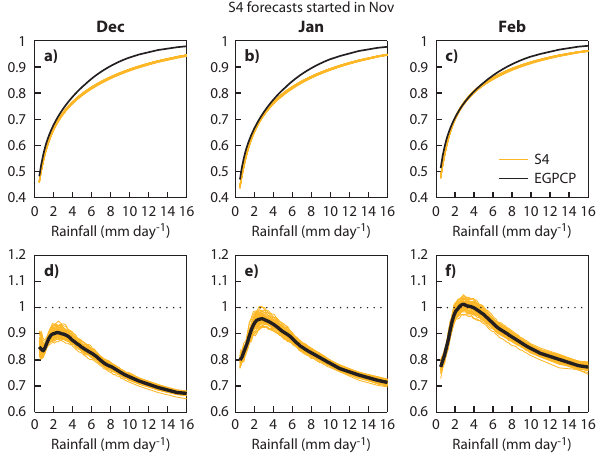
Figure 4. Cumulative density function (CDF) (a–c) of daily precipi- tation from EGPCP (black) and SYS4 forecasts started in November (grey lines from the bootstrapping sampling) and valid for Decem- ber (a) , January (b) and February (c) . Quantile match coefficients applied to correct SYS4 forecasts (black mean, grey bootstrapping range) started in November and valid in December (d) , January (e) and February (f) . The represented CDFs and quantile match coeffi- cients were averaged over the region (27 to 32 ◦ E; − 22 to − 25 ◦ N).